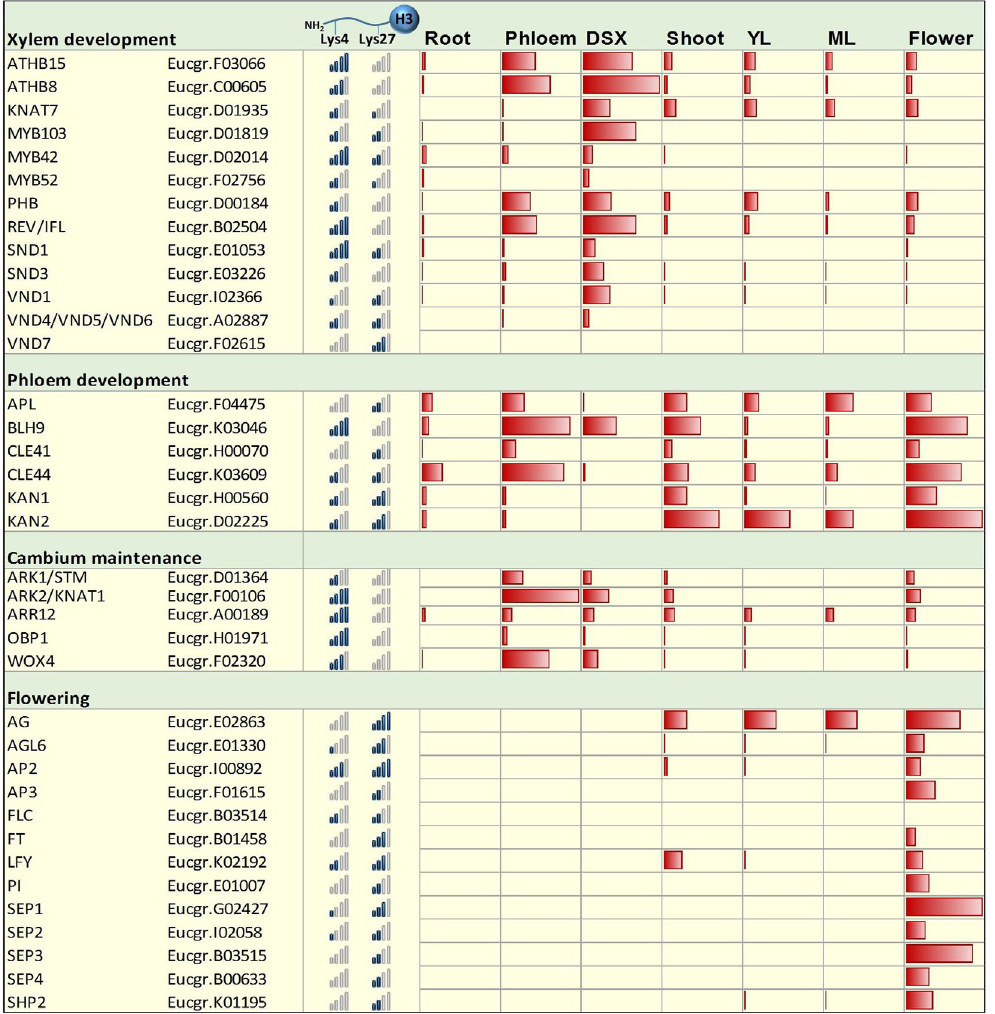
Figure 3. Relative enrichment of H3K4me3 and H3K27me3 for E. grandis homologs of transcription factors and signal peptides regulating vascular development and flowering in developing secondary xylem tissue. Blue bars, enrichment of H3K4 and H3K27 trimethylation (shown as N-terminal region of histone H3), represented as a signal of zero (no significant enrichment) to four bars (16-fold enrichment). Red bars, absolute RNA-seq expression levels (max FPKM value, 228) for roots, phloem, developing secondary xylem (DSX), shoots, young leaves (YL), mature leaves (ML) and flowers 41, 42